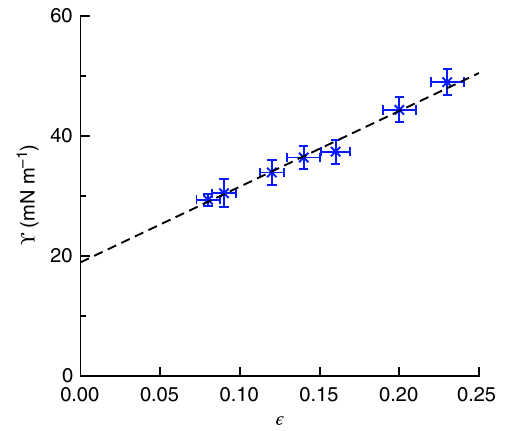
Fig. 3 Strain dependence of solid surface stress, ϒ ( ϵ ). The points indicate the average surface stress and average local strain for droplets on the same substrate. The error bars are the SD of the population. The dashed line is a linear fi t, providing the surface modulus, Λ = 126 ± 6 mN m − 1 and zero- strain surface stress, ϒ 0 = 19 ± 3 mN m −